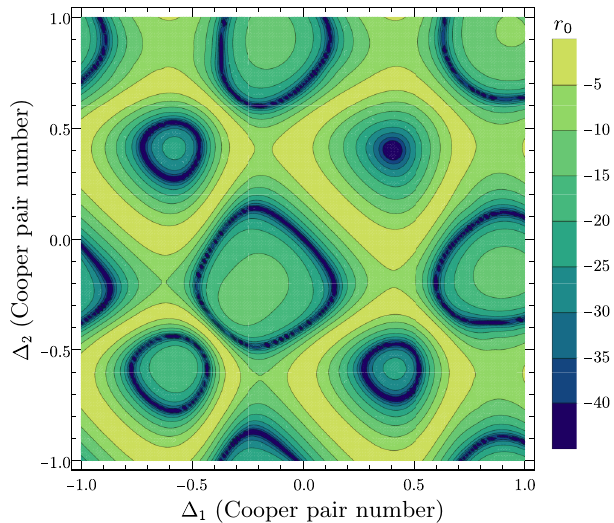
FIG. 9. The effect of offset charge number variations from the ideal on the minimum of the extinction ratio r 0 (in decibels) between port 1 and port 2. Shown is the two-dimensional slice for (cid:20) 3 = 0 (i.e., an unchanged N g 3 ) while introducing variations (cid:20) − 1 to + 1 in N (cid:20) 1 and 2 from g 1 and N g 2 , respectively. The parameters and offset charge for ideal tuning are the same as in Fig.